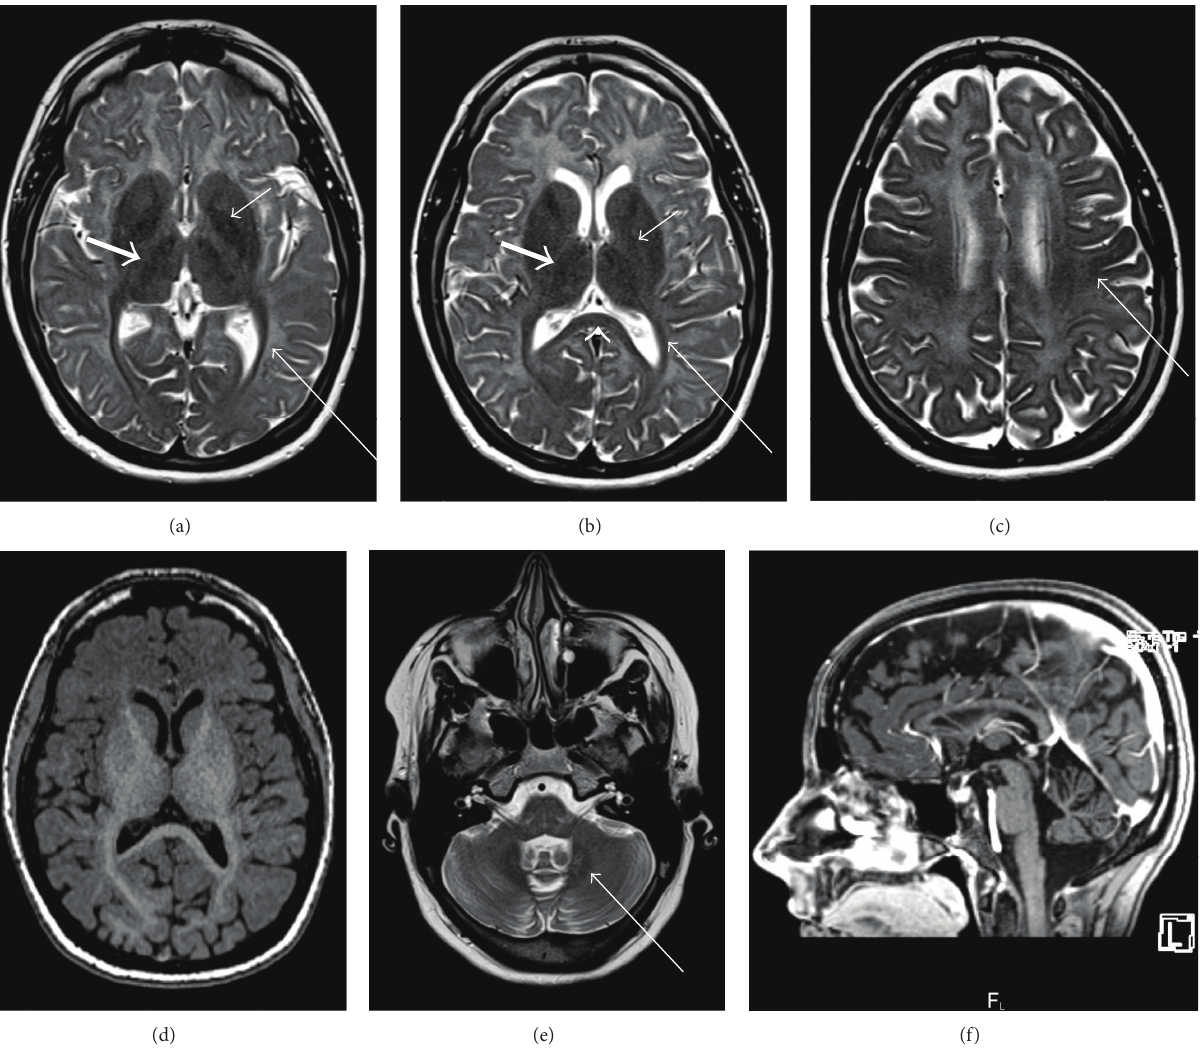
Figure 2: MRI of the brain performed at the age of 28, demonstrating evidence of a hypomyelinating leukodystrophy. Compared to grey matter structures, there is diffuse hyperintensity of the white matter on T2 weighted images (a, b, c), with hyperintense signal on T1 weighted images (d), consistent with hypomyelination. As previously reported, there is characteristic relative preservation of myelination within the following structures: optic radiations (long thin white arrow; a, b), anterolateral nucleus of the thalamus (thick white arrow; a, b), globus pallidus (short thin white arrow; a, b), posterior corpus callosum (white arrow head; b), corticospinal tracts (white arrow; c), and the dentate nucleus (white arrow; e). Sagittal T1 weighted imaging (f) demonstrates thinning of the corpus callosum and mild cerebellar